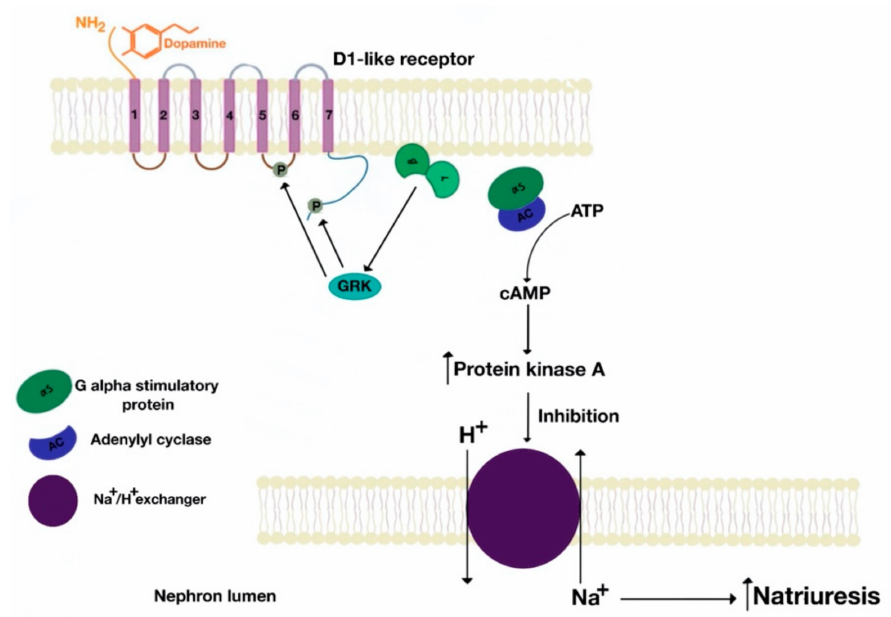
Figure 11. D1-like receptors are linked to G α s